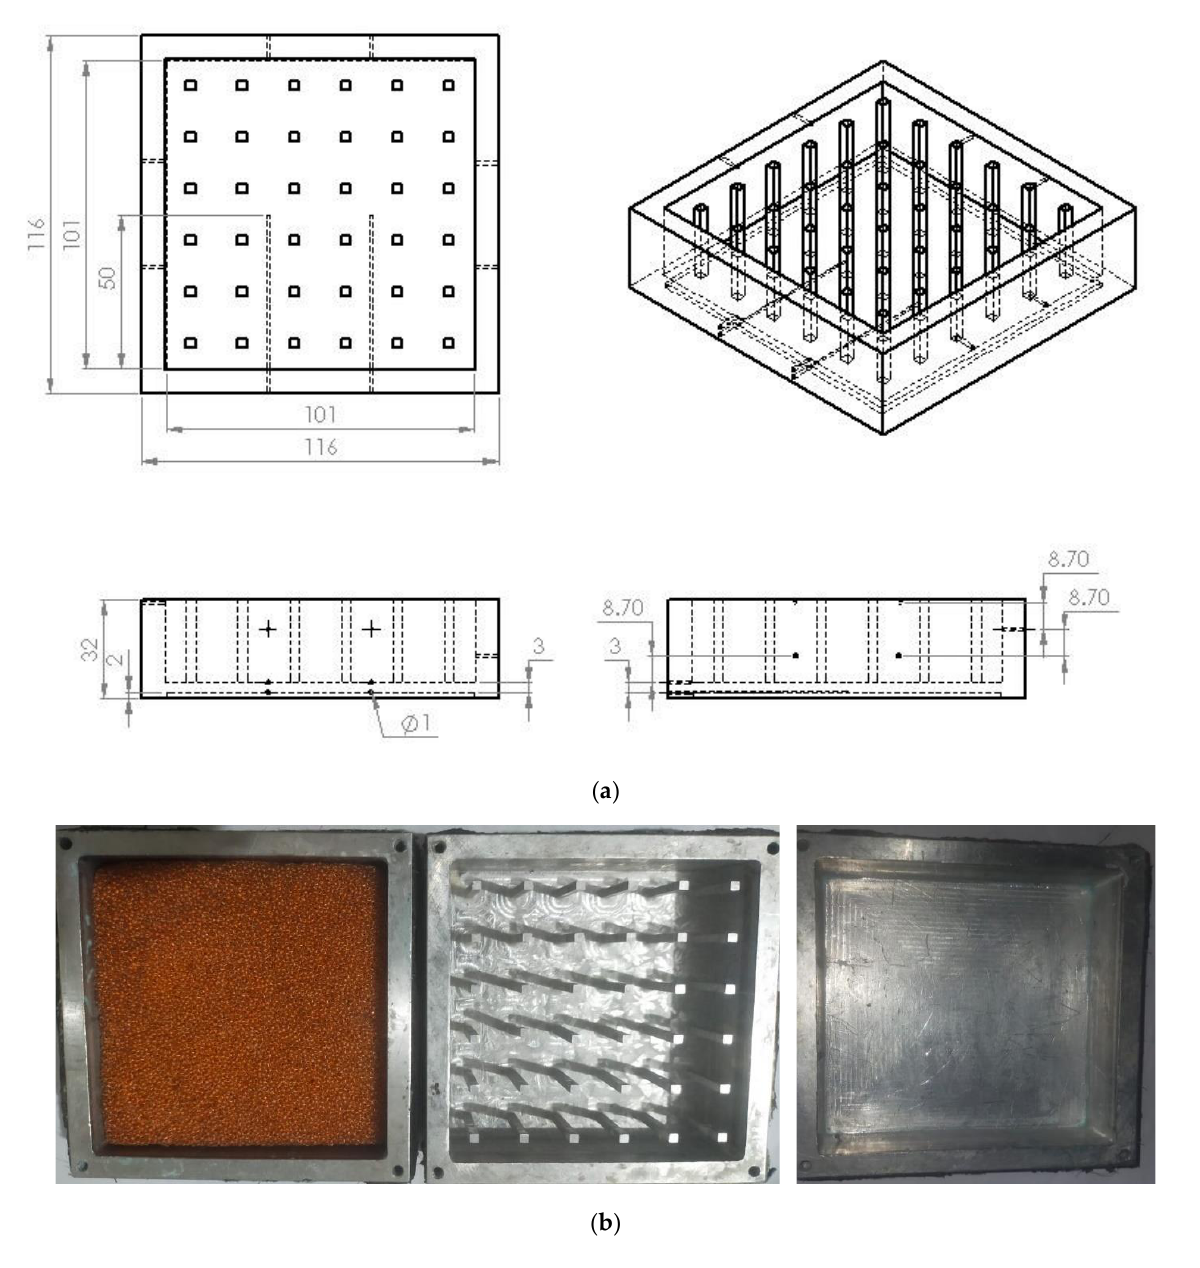
Figure 3. ( a ). Isometric views of the square pin-fin heat sink (mm). ( b ). Pictorial views of the SHS, Figure 3. ( a ) Isometric views of the square pin-fin heat sink (mm). ( b ) Pictorial views of the SHS, S pf HS, and Cu fm HS. S pf HS, and Cu fm